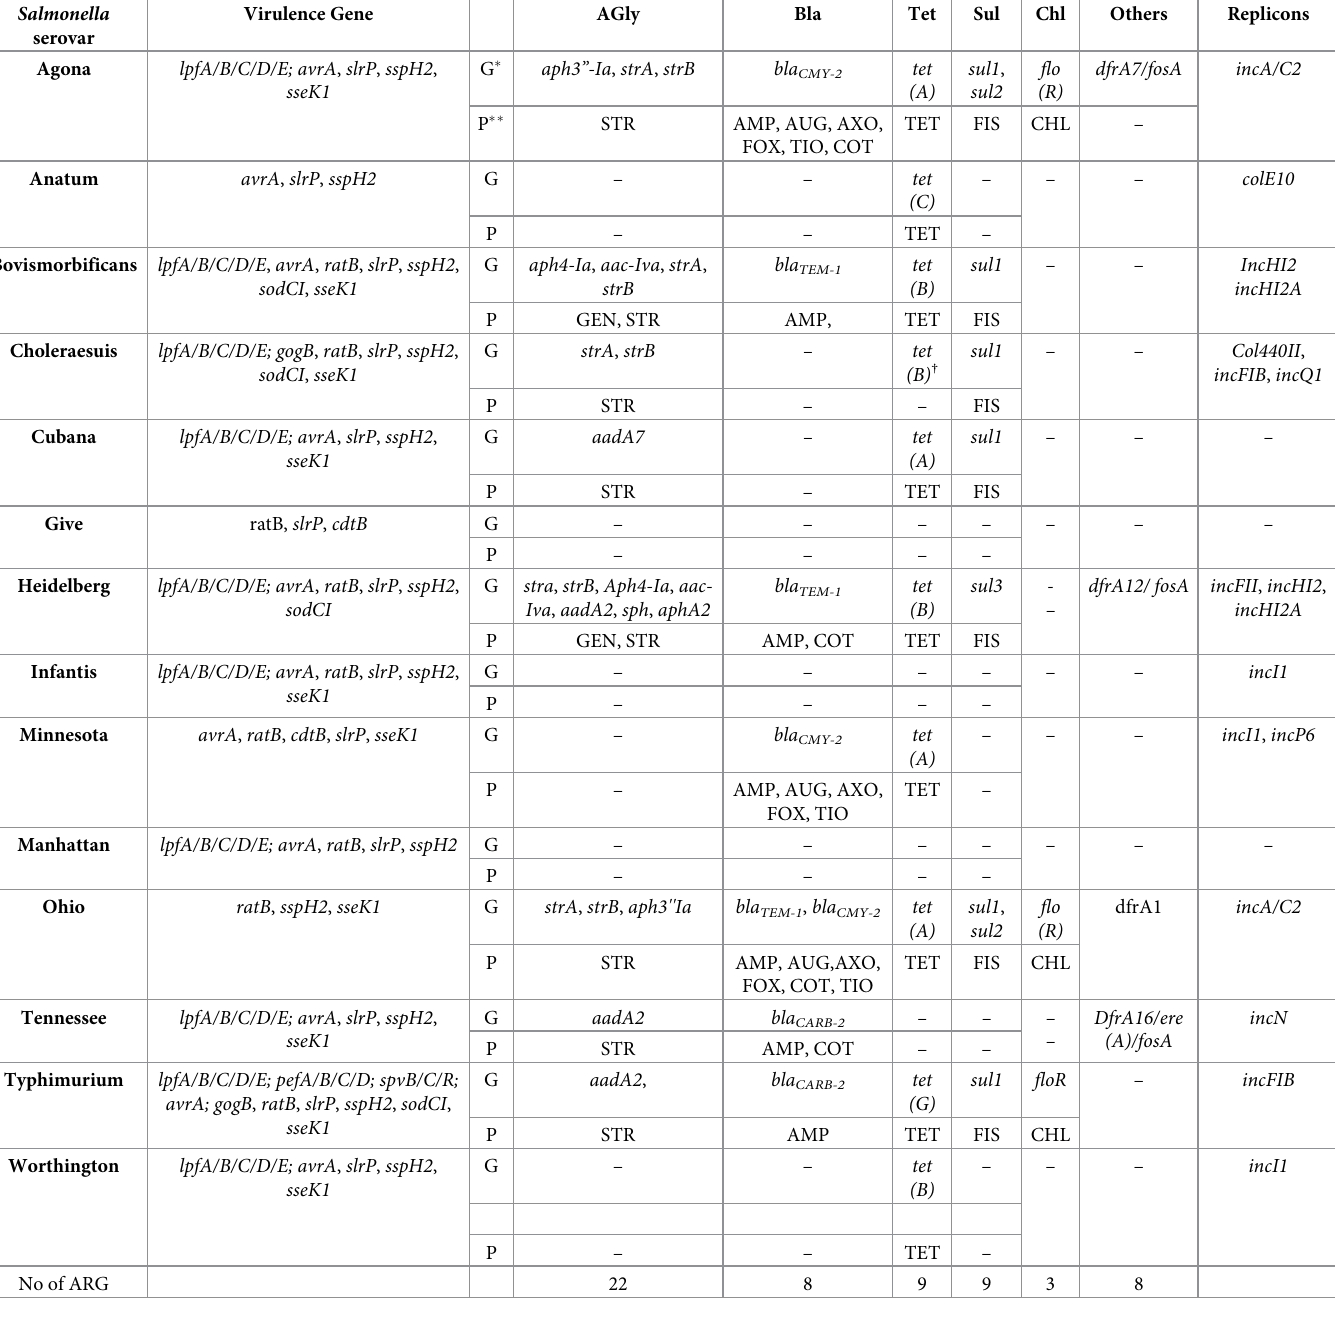
Table 2. Antibiotic resistance phenotype and predicted antibiotic resistance and virulence genes in different Salmonella serovars. Salmonella